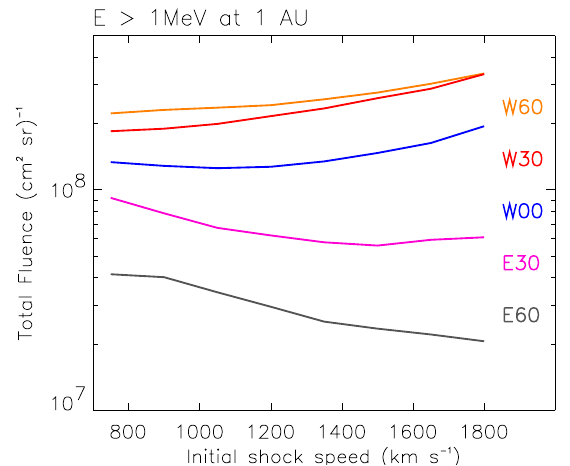
Fig. 5. Total fluence, calculated as in Fig. 4, of protons above 1MeV as a function of the initial shock speed and the heliolongitude, for observers located at 0.4 AU. For simplicity, the plot only shows 6 cases (color coded) among the 14 possible